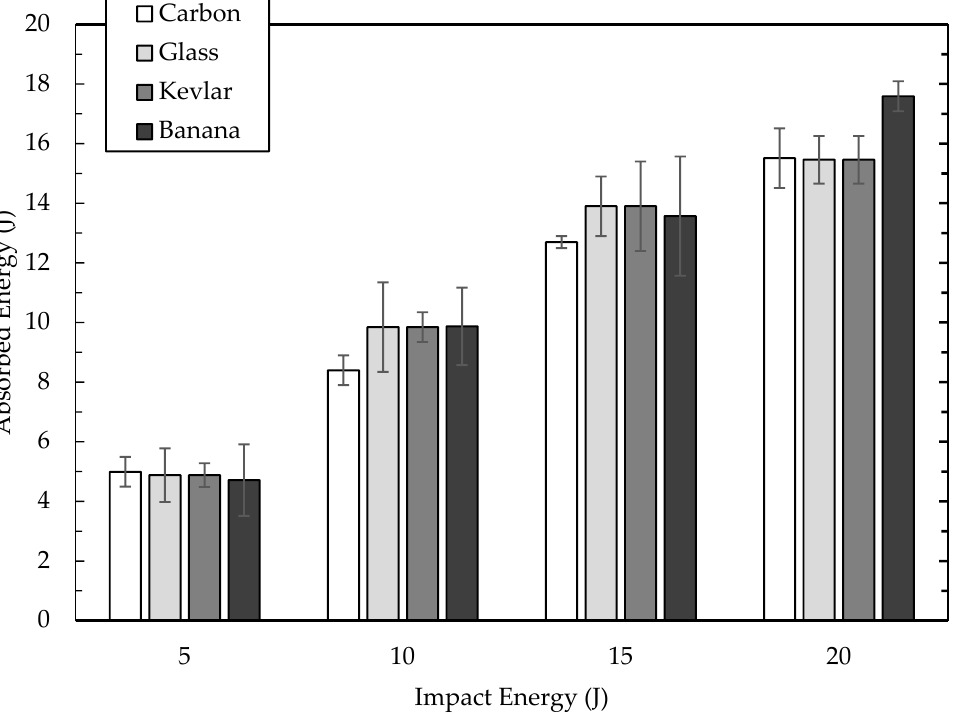
Figure 8. Typical absorbed energies at various incident energy levels.